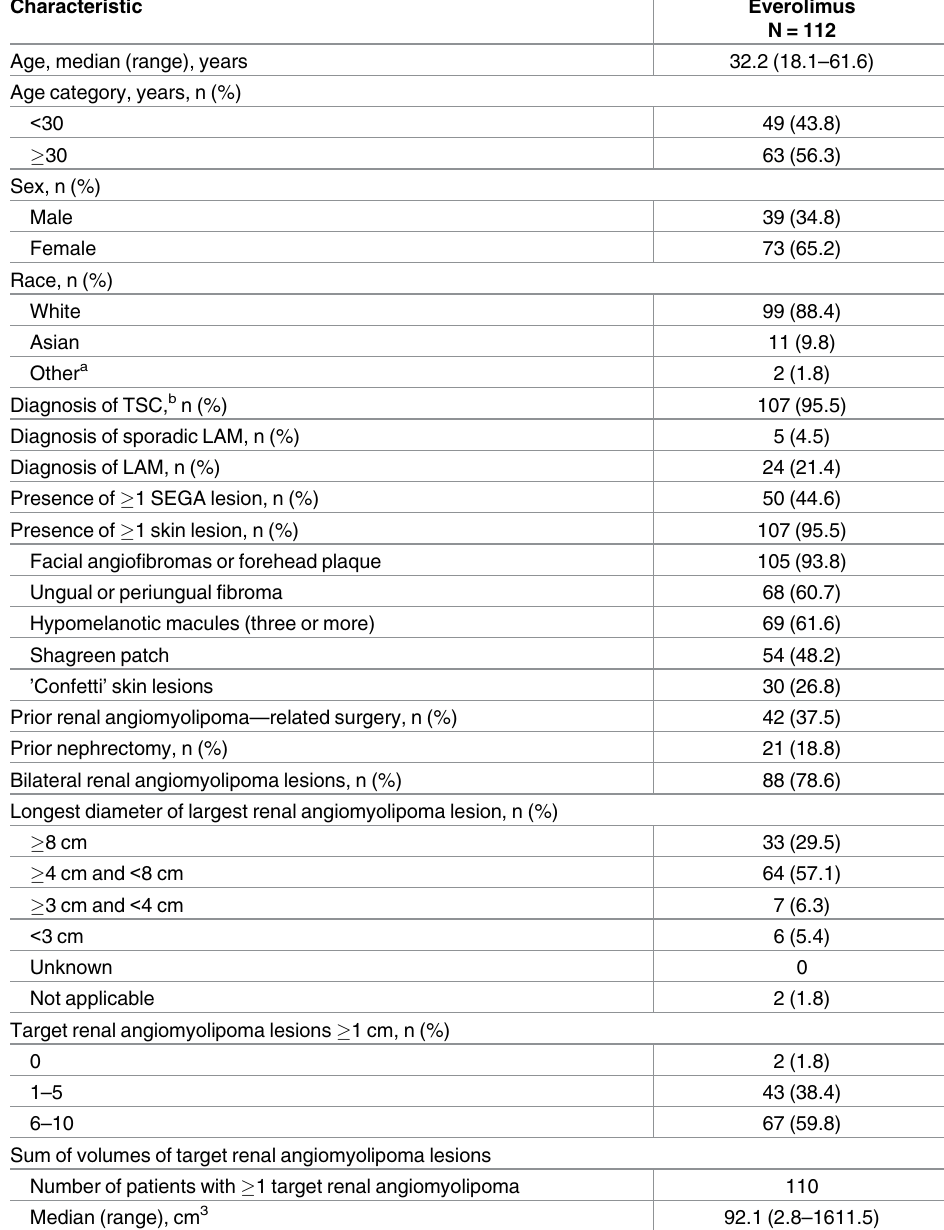
Table 1. Patient baseline